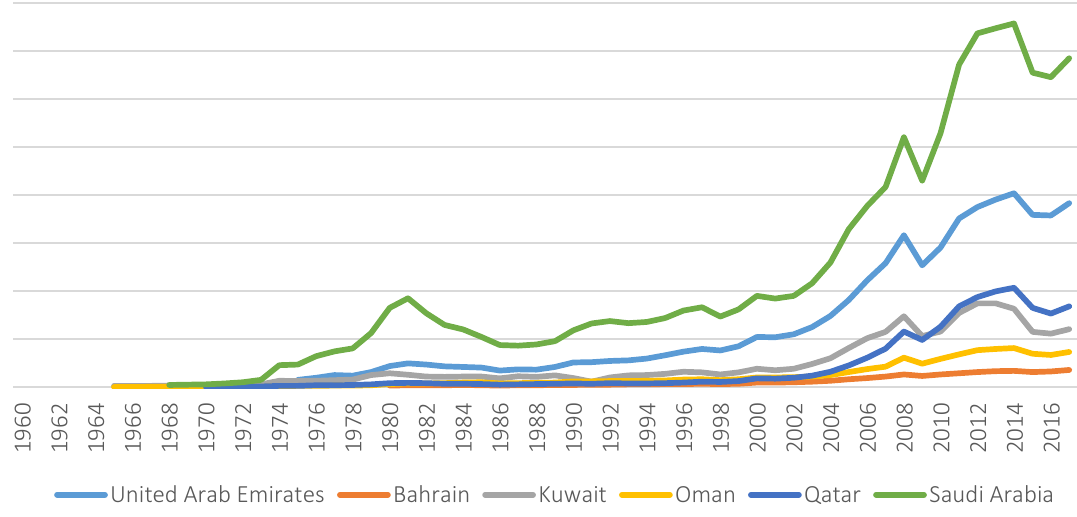
Figure 1. Gross domestic product (current USD)